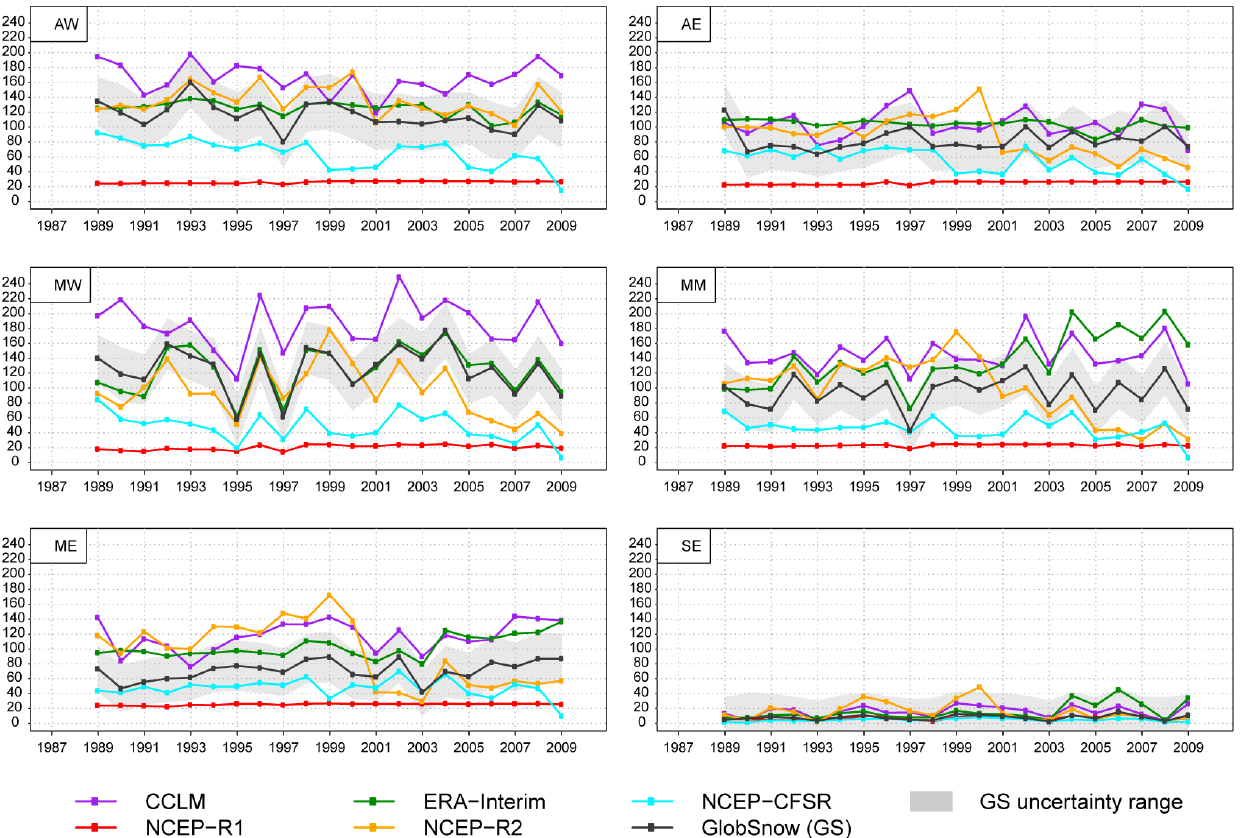
Fig. 6. As Fig. 5. – mean April values are